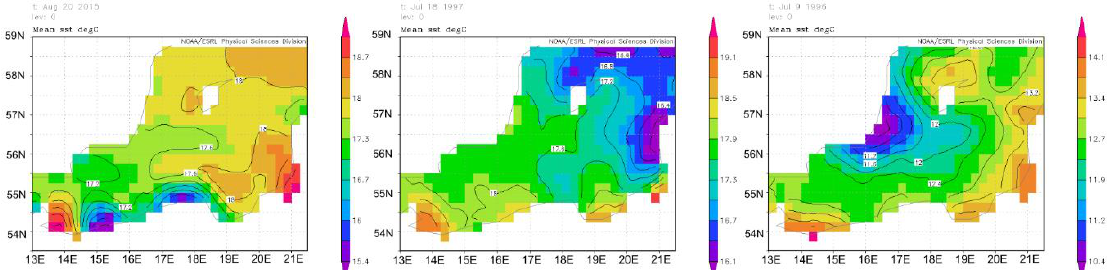
Figure 2. Examples of sea surface temperature (SST) distribution showing upwelling in di ff erent regions of southern Baltic Sea based on the NOAA OI SST V2